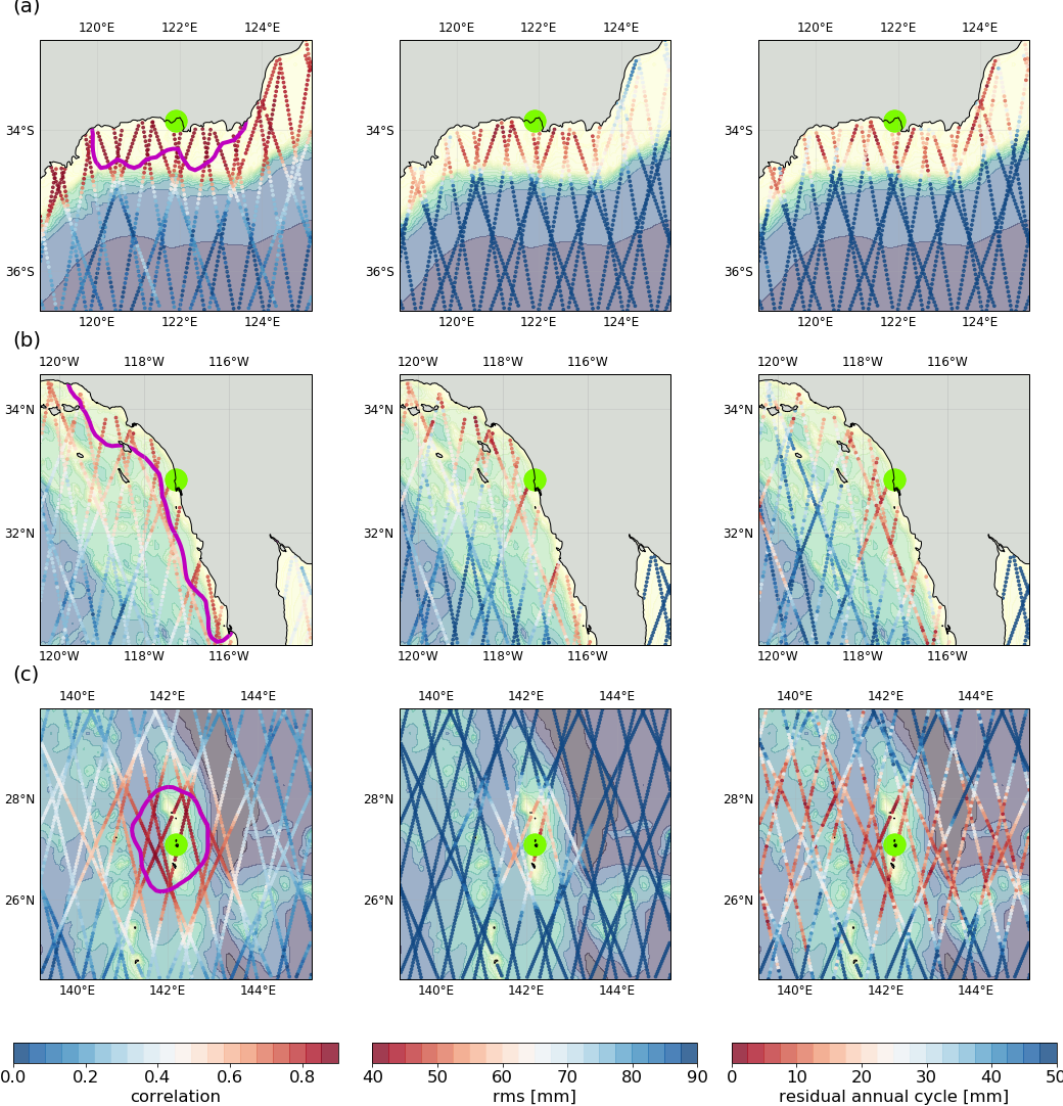
Figure 1. Zone of influence: different coherent zones of sea level variability are identified by different statistical criteria S . The columns show correlations, rms SAT-TG and the residual annual cycle from left to right. The metrics are computed on every point of the 1Hz along- track product, comparing the performance of altimetry measurements with the TGs, highlighted in green (center). (a) The southern coast of Western Australia, (b) the western coast of North America (TG in San Diego) and (c) Chichijima island (Japan). The “color” contour in the first column indicates a zone of influence built from 20% of the best-correlated SLAs within a 300km radius. The underlying contours denote the underlying